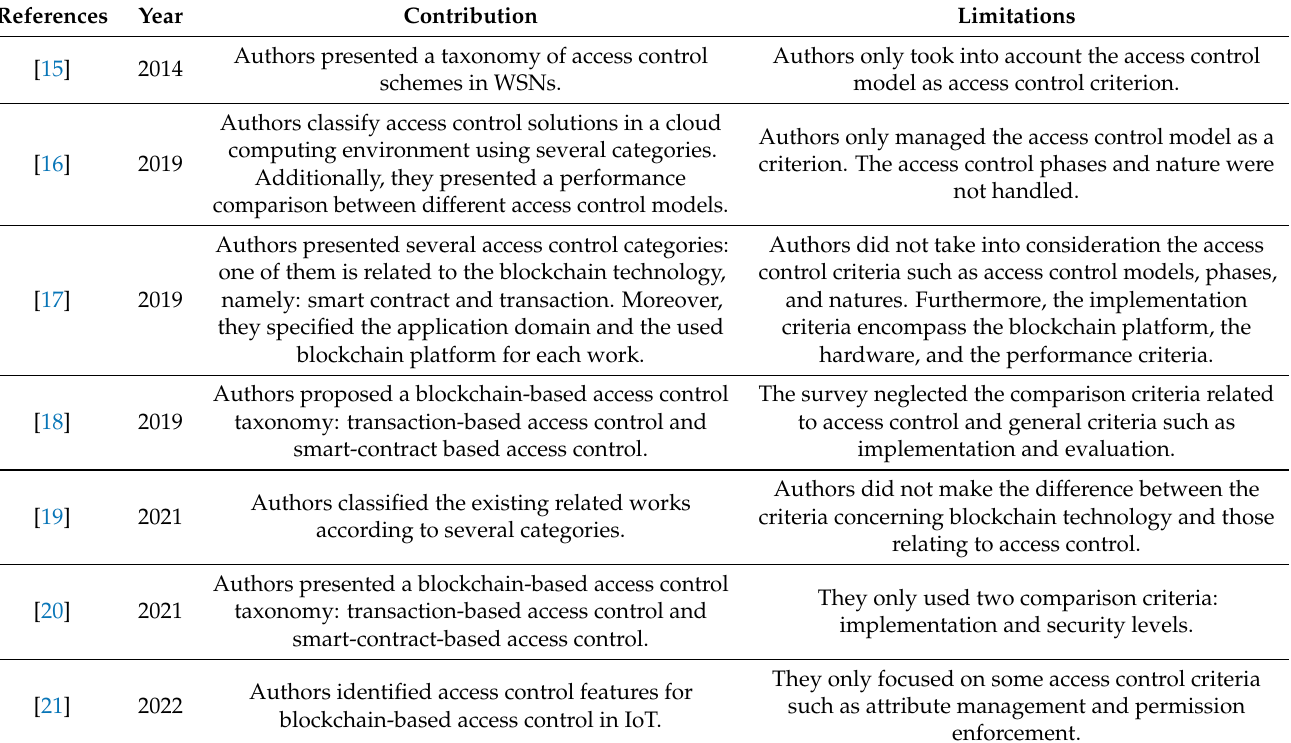
Table 1. Related works’ contributions and